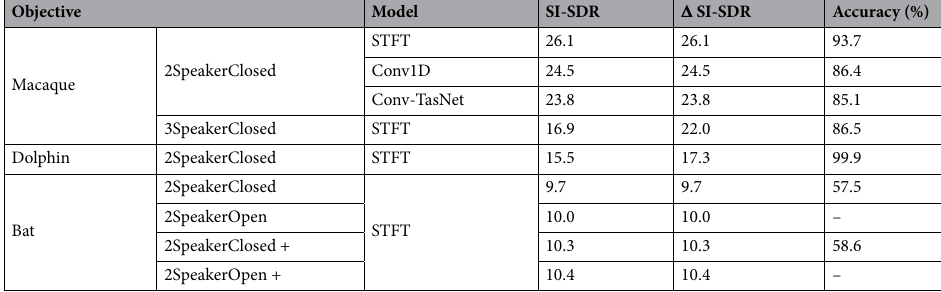
Table 1. Summary of experiments implemented in this study organized according to species, number of speakers, open/closed speaker regime, and model architecture. STFT represents the model with STFT encoder and iSTFT decoder, and Conv1D represents the fully time domain model with Conv1D encoder and ConvTranspose1D decoder. The + denotes the expanded training dataset. We report SI-SDR with ( (cid:31) ) and without improvement over input SI-SDR averaged over